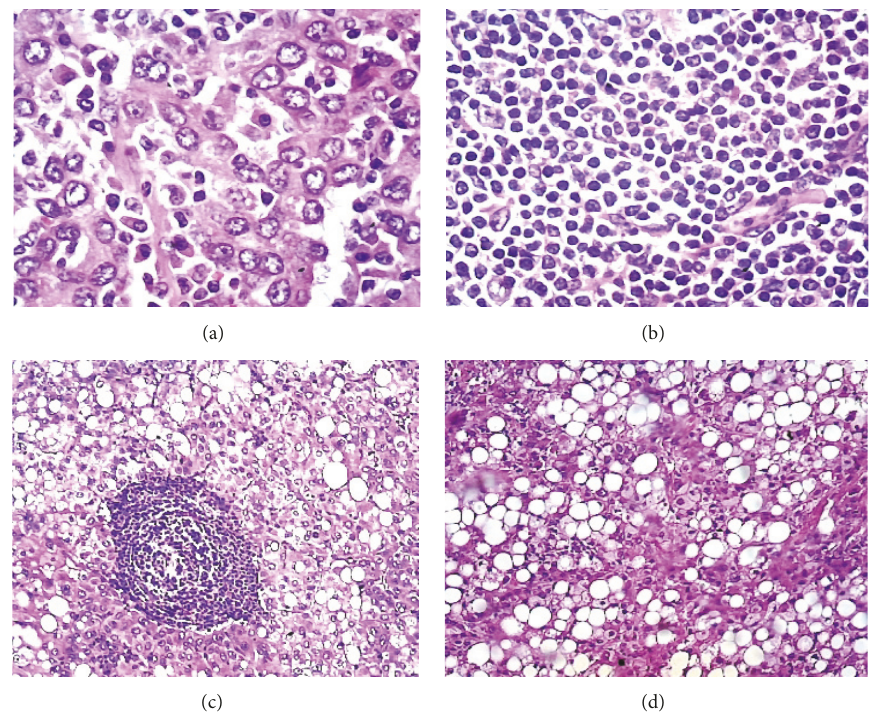
Figure 4: (a) Lymphoid cells invading sinusoidal spaces ( HE 200x ); (b) diffuse lymphoid infiltration ( HE 200x ); (c) nodular lymphoid aggregate ( HE 200x ); (d) area of steatosis ( HE 100x ).